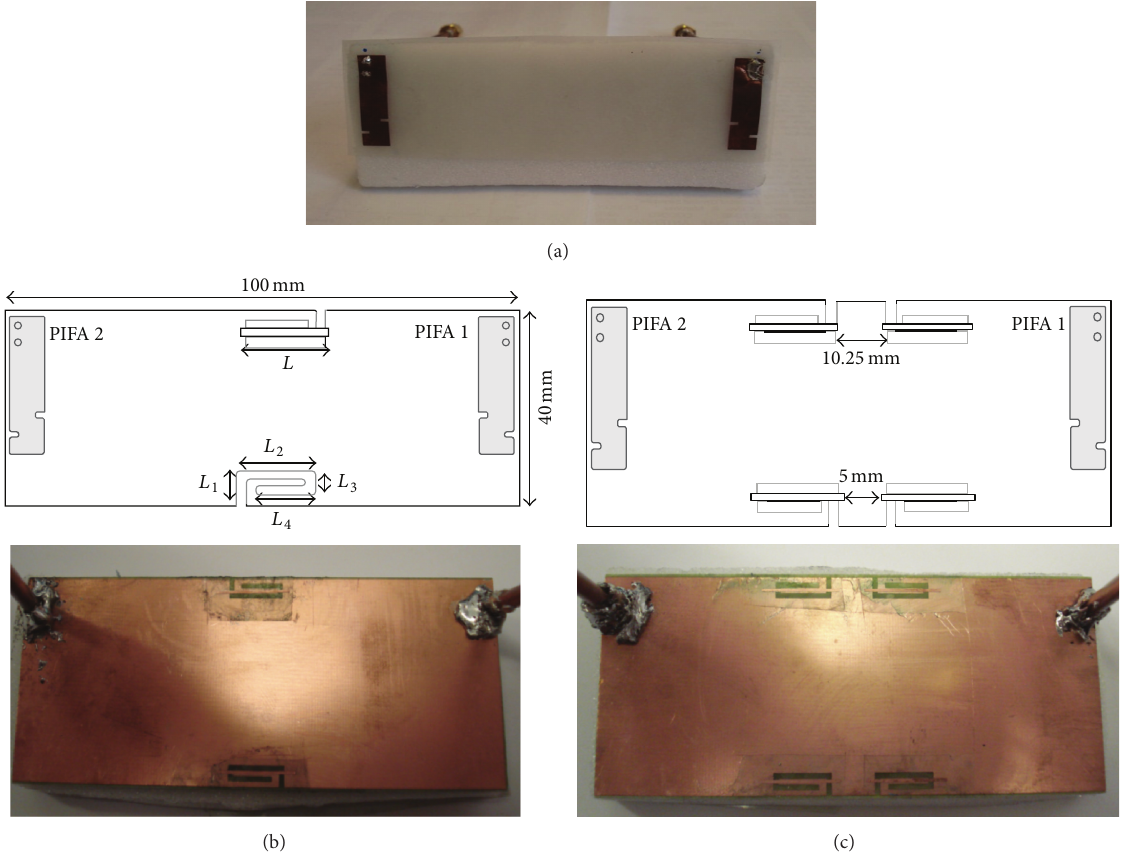
Figure 6: (a) Two-element PIFA array with (b) two convoluted double-layered structures and (c) four convoluted double-layered